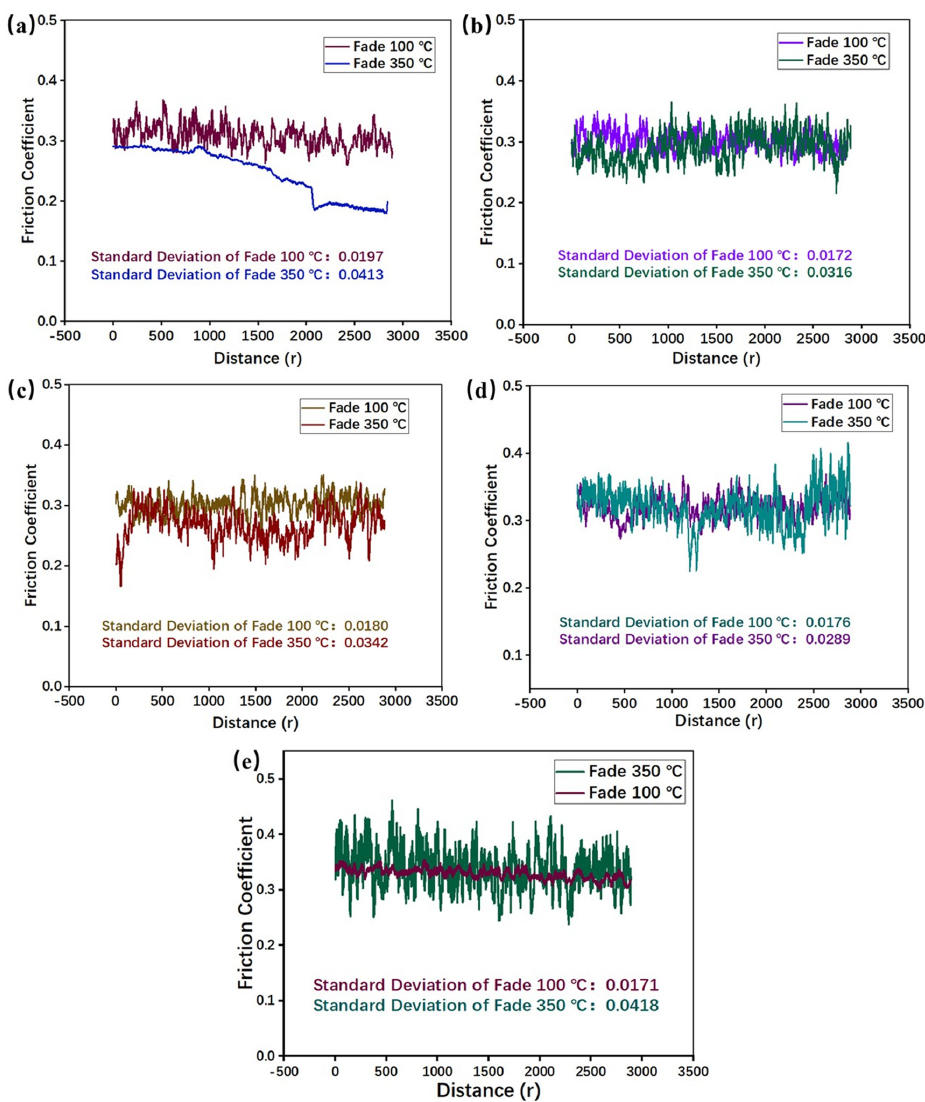
Figure 7. Brake curves of samples during the fade test at 100 °C and 350 °C; ( a ) RBFM-1, ( b ) RBFM- ( c ) RBFM-3, ( d ) RBFM-4, ( e ) 2, ( c ) RBFM-3, ( d ) RBFM-4, ( e ) RBFM-5.